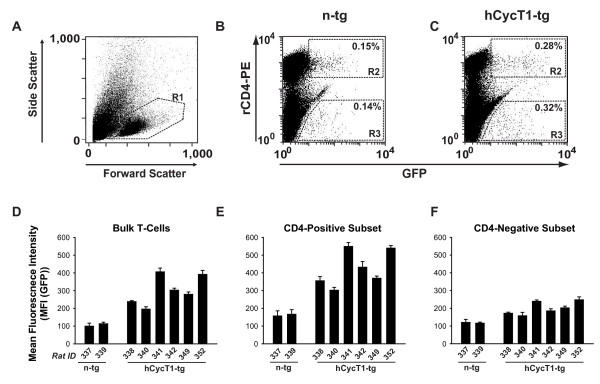
Functional analysis of hCycT1 transgenesis in T-cell bulk cultures from rats mirrors the subset-specific impact in CD4 T-cells. Activated, spleen-derived T-cell cultures from six hCycT1-tg and two n-tg rats were infected with VSV-G HIV-1NL4-3 GFP. (A-C) Three days later, cells were stained with a rCD4-PE antibody (clone OX-8) and analyzed for GFP expression in CD4-positive or CD4-negative T-cells. Shown are representative flow cytometry dot plots of (A) viable cells identified by FSC/SSC characteristics (R1 gate), or infected, stained T-cells from one (B) n-tg or (C) hCycT1-tg rat with double-positive cells and corresponding MFI values indicated in gates R2 (rCD4-positive cells) and R3 (rCD4-negative cells). The percentage of rCD4-positive cells of all viable, rCD3-positive lymphocytes were (B) 61% (and 39% CD8-positive T-cells), and (C) 27% (and 73% CD8-positive T-cells). The CD4low sub-population in B and C likely reflects residual monocytes. (D-E) Quantitative analysis of early HIV-1 gene expression, represented by the MFI (GFP) in infected T-cell subsets: (D) bulk T-cells, (E) CD4-positive T-cells, (F) CD4-negative T-cells. Histogram bars depict the arithmetic means + SD of triplicates.